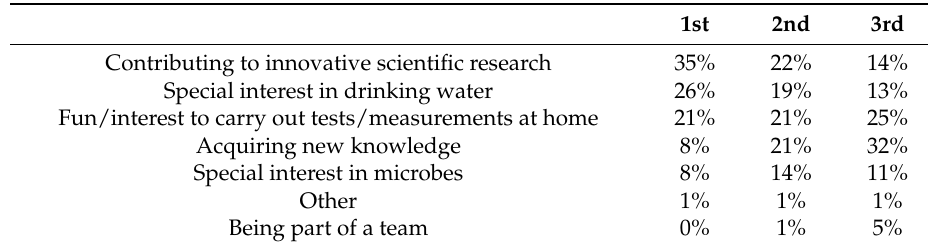
Table 1. The 1st, 2nd, and 3rd most important motivation for volunteers to participate in the ‘Freshness of Water’ citizen science